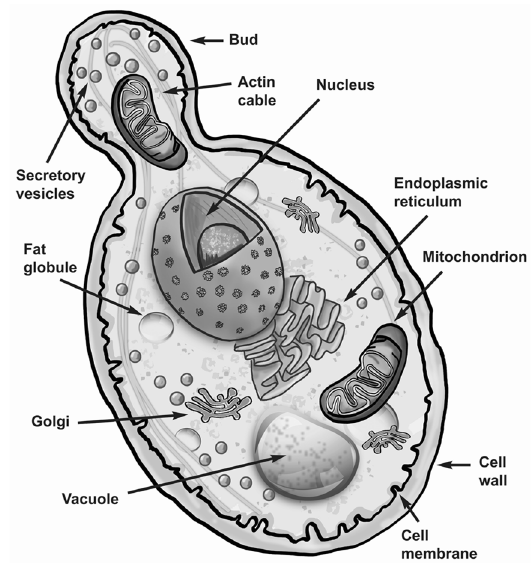
Figure 2. Main features of a typical Saccharomyces cerevisiae cell.